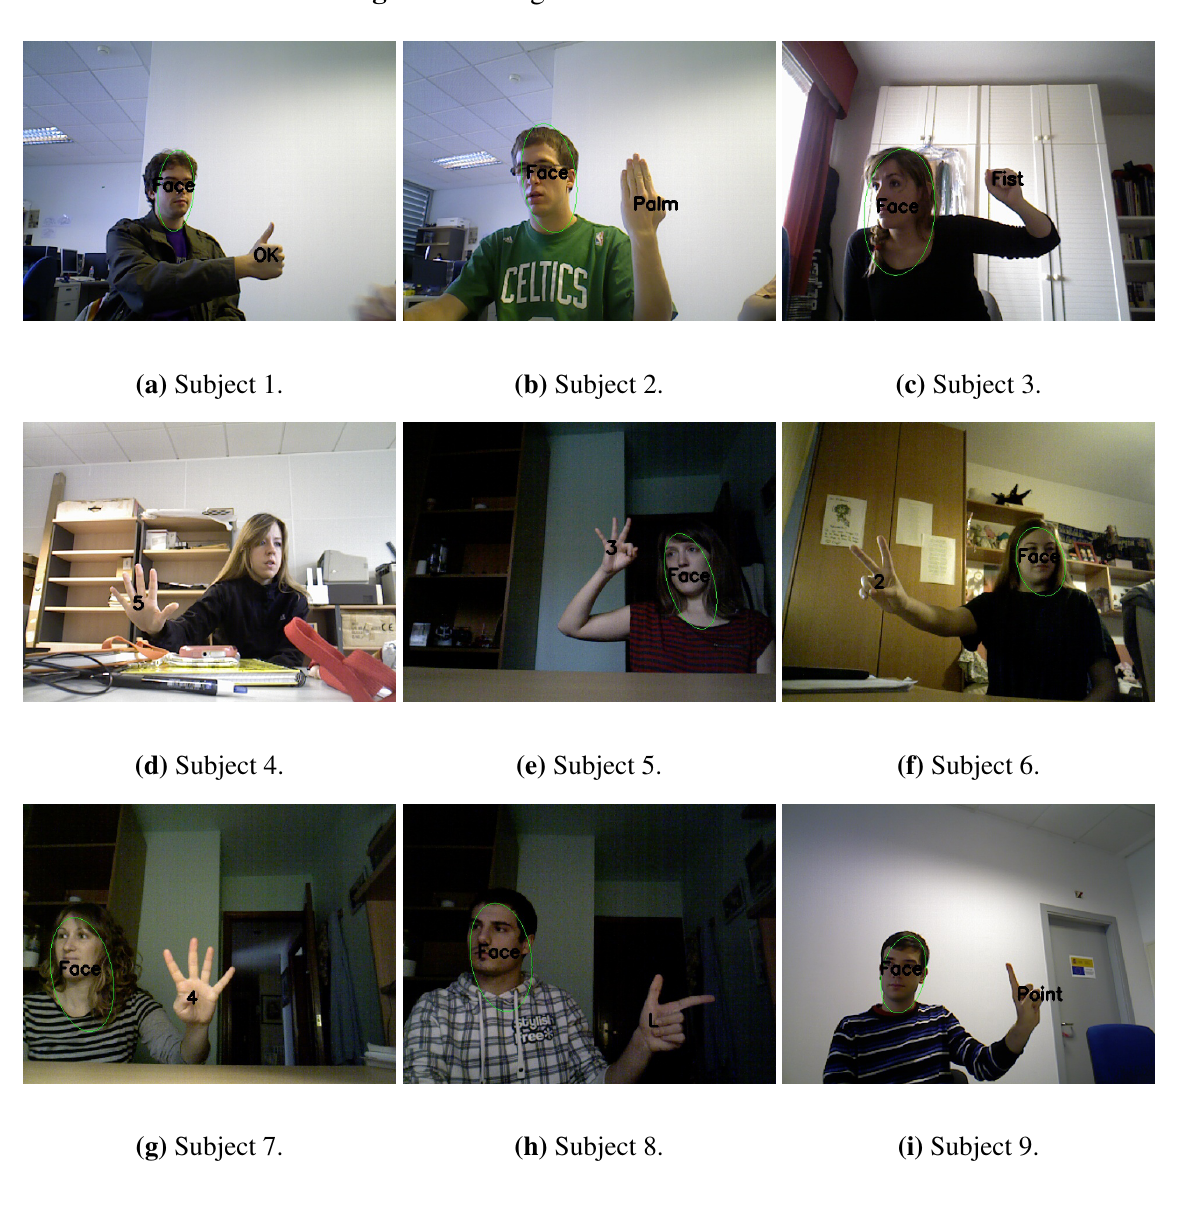
Figure 11. Images of the different